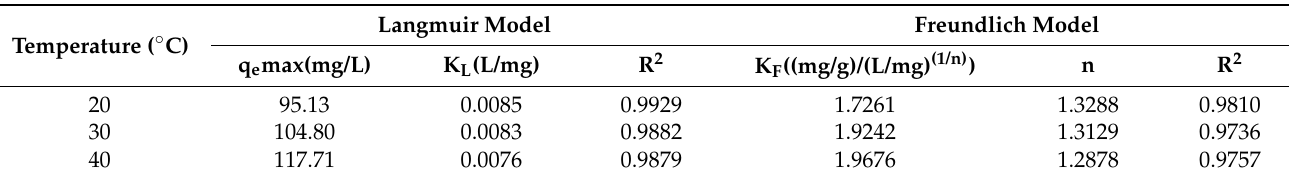
Table 3. Fitting constants of two isotherm models for different adsorbents.